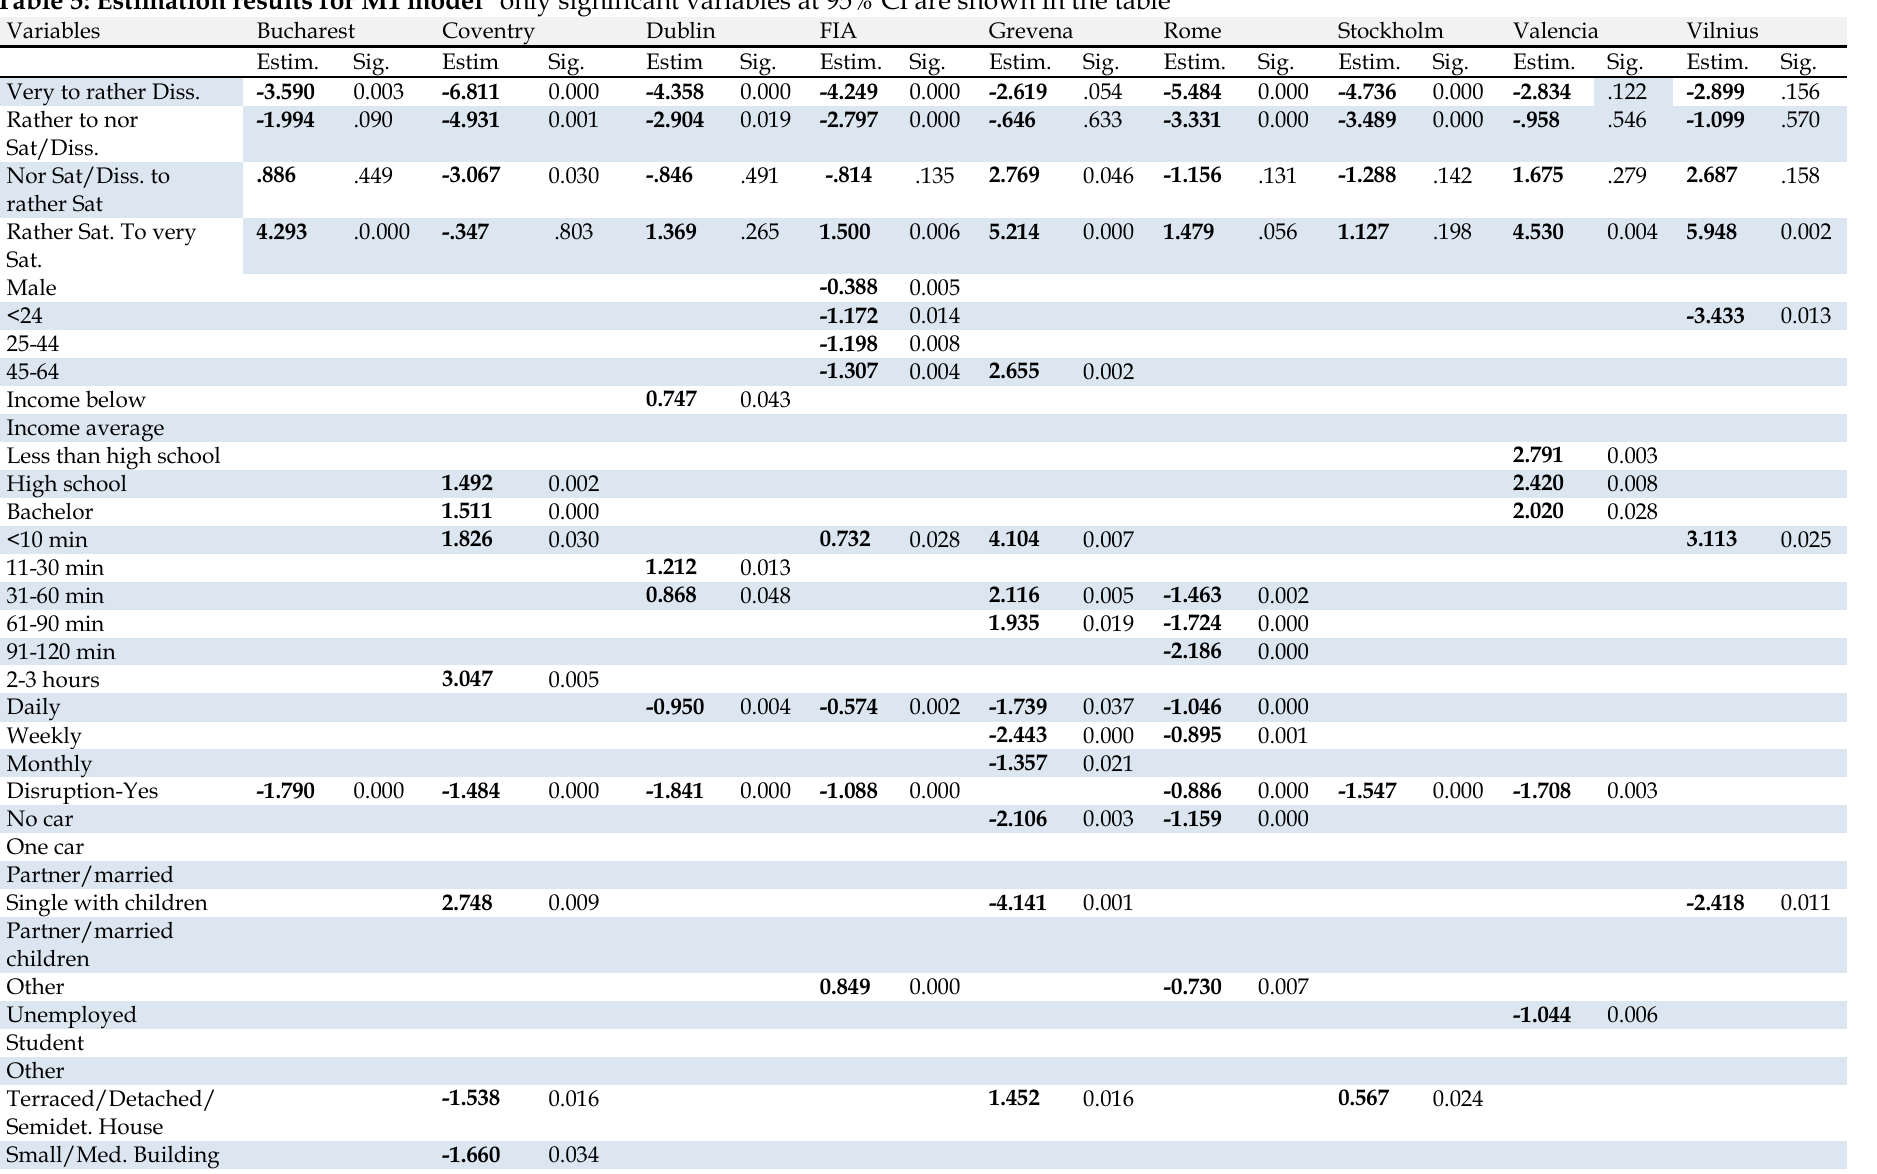
Table 5: Estimation results for M1 model *only significant variables at 95% CI are shown in the table